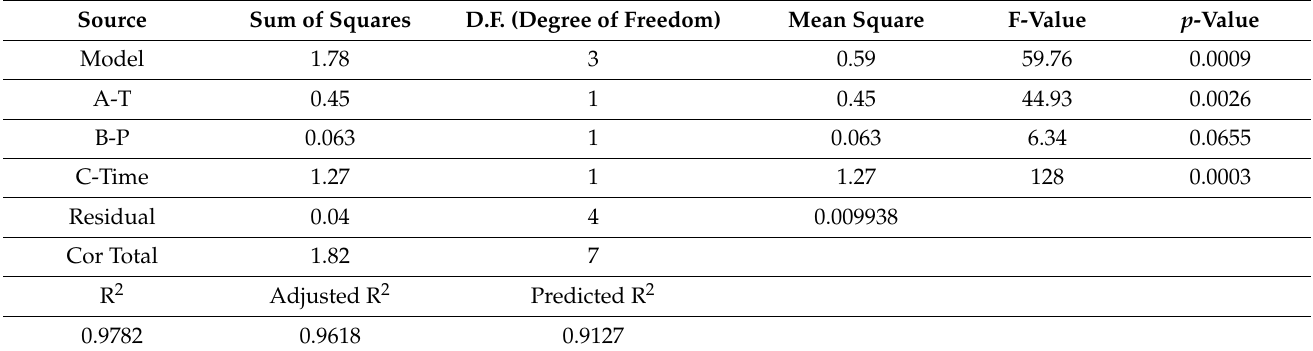
Figure 5. Diagnostic plots (predicted vs. actual) of model adequacy for the extraction. Table 5. Analysis of variance (ANOVA) for the model fitted to the SSI